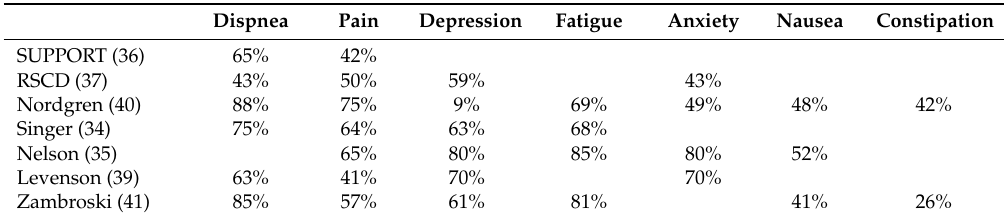
Table 1. Main symptoms prevalence at the end of life in patients with heart failure. The numbers